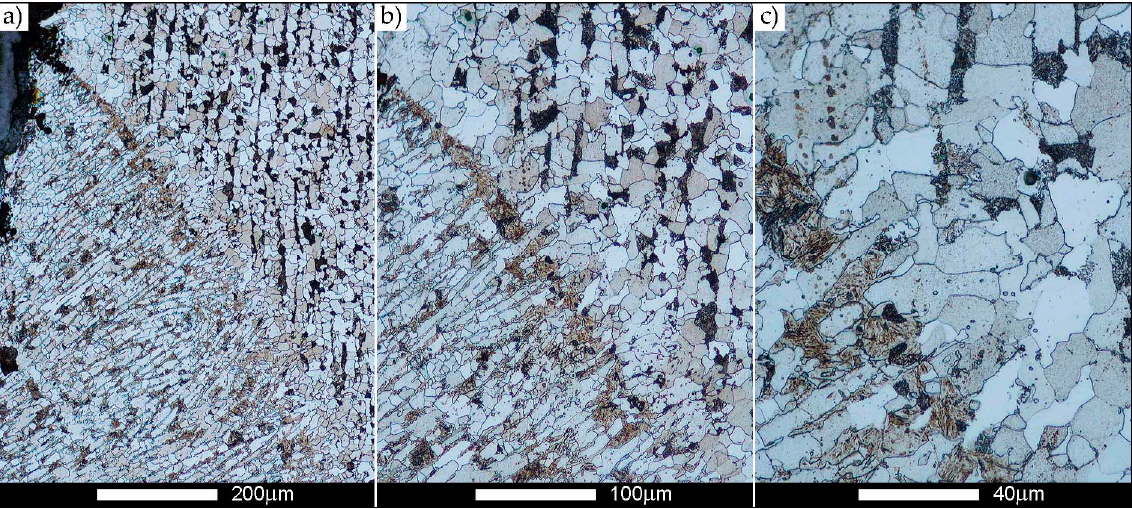
Figure 50. Welded joint microstructure of Hardox 450 in the delivery state (directly after welding) with visible prior austenite grain boundaries—FL zone shown in Figure 2. ( a ) 100×; ( b ) 200×; ( c ) 500×.